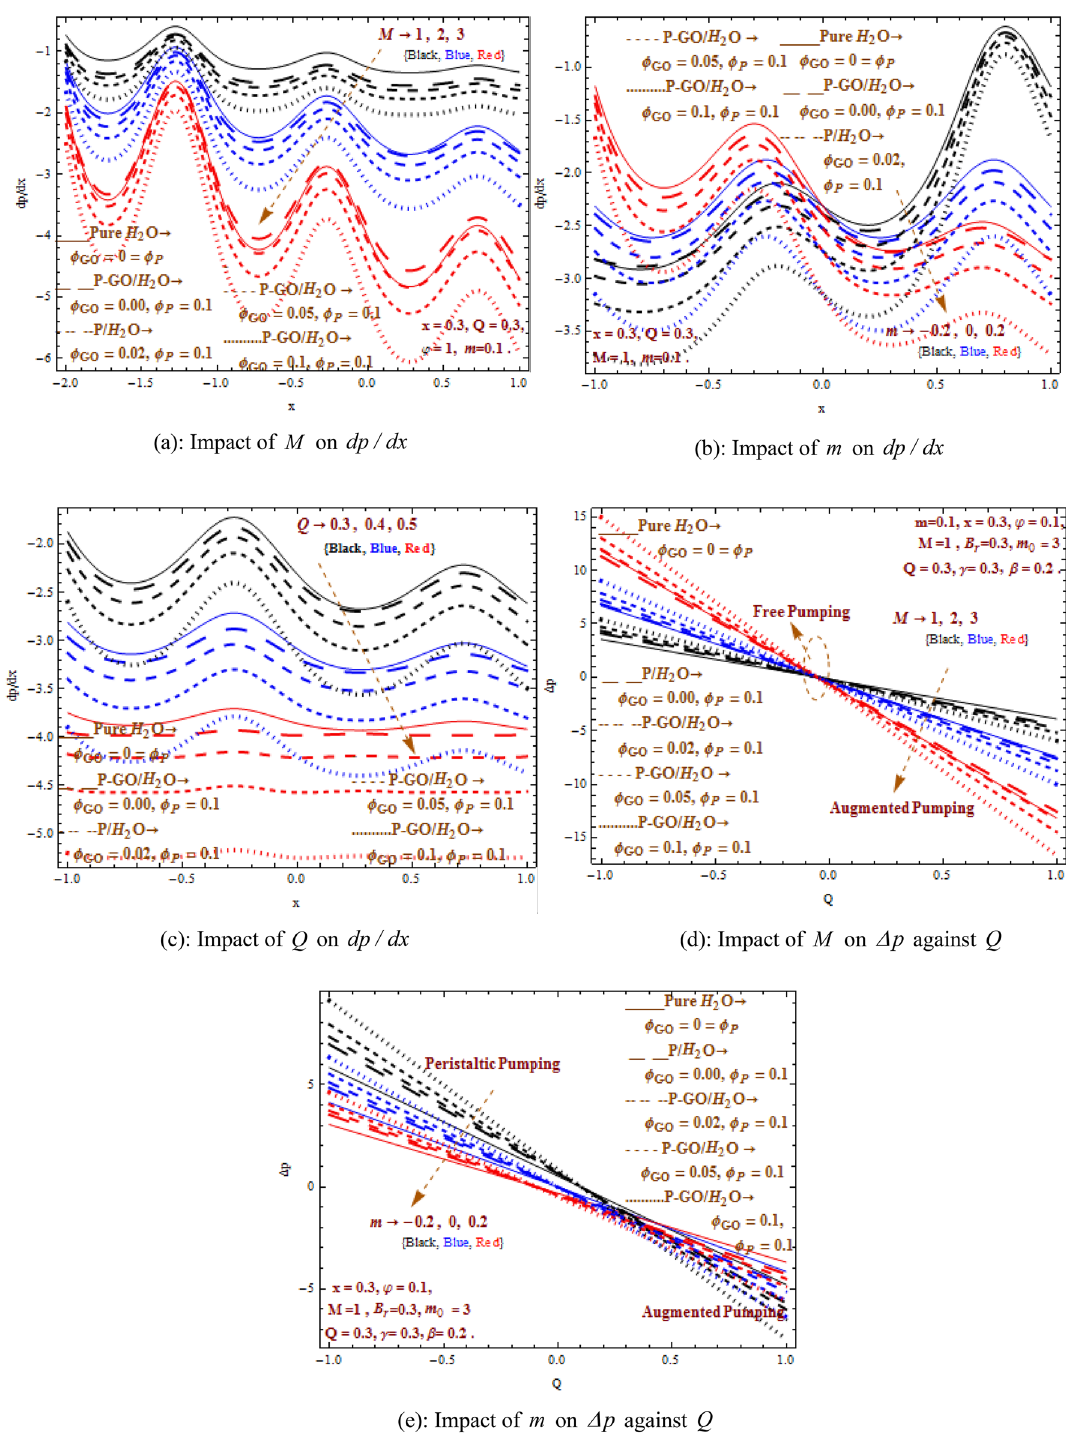
Figure 6. ( a ) Impact of M on dp / dx . ( b ) Impact of m on dp / dx . ( c ) Impact of Q on dp / dx . ( d ) Impact of M on (cid:31) p against Q . ( e ) Impact of m on (cid:31) p against Q